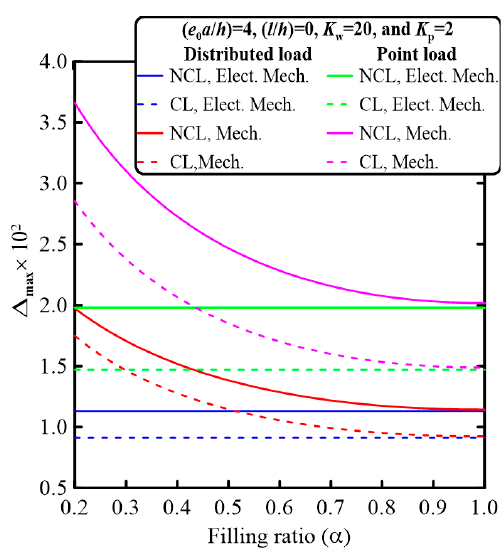
Figure 6. Variation in the maximum transverse deflection Δ max with the perforation filling ratio α for nonclassical and classical electromechanical and mechanical behavior under uniformly distributed and point loads at different values of the nonclassical and elastic foundation parameters at N = 4 and beam aspect ratio L / h = 20, α = 0.2 to 1, e 311 = − 4.1 C/m 2 , μ 3111 = 5 × 10 − 8 C/m, a 33 = 7.124 × 10 − 9 C/m 2 K, and K p = 0, 2 and K w = 0, 20. For quantitative investigation of the significant effect of the perforation filling ratio α on the maximum nondimensional transverse deflection, the relative percentage differ- ence of the maximum nondimensional transverse deflection due to increasing α at a con- stant value of the number of hole rows N is given by (%𝐷∆ (cid:3040)(cid:3028)(cid:3051) ) (cid:3080) = 100 × 𝑎𝑏𝑠 (cid:4674) (∆ (cid:3288)(cid:3276)(cid:3299) ) (cid:3209)(cid:3128)(cid:3116).(cid:3118) (cid:2879)(∆ (cid:3288)(cid:3276)(cid:3299) ) (cid:3209)(cid:3128)(cid:3117) (∆ (cid:3288)(cid:3276)(cid:3299) ) (cid:3209)(cid:3128)(cid:3117) (cid:4675). Table 5 shows the relative percentage difference (%𝐷∆ (cid:3040)(cid:3028)(cid:3051) ) (cid:2961) for the electromechanical and mechanical nonclassical and classical behaviors at different values of the elastic foundation and nonclassical parameters for point and uniformly dis- tributed loading conditions. It is seen that the filling ratio significantly affects the mechan- ical transverse deflection, while it has an insignificant influence on the electromechanical